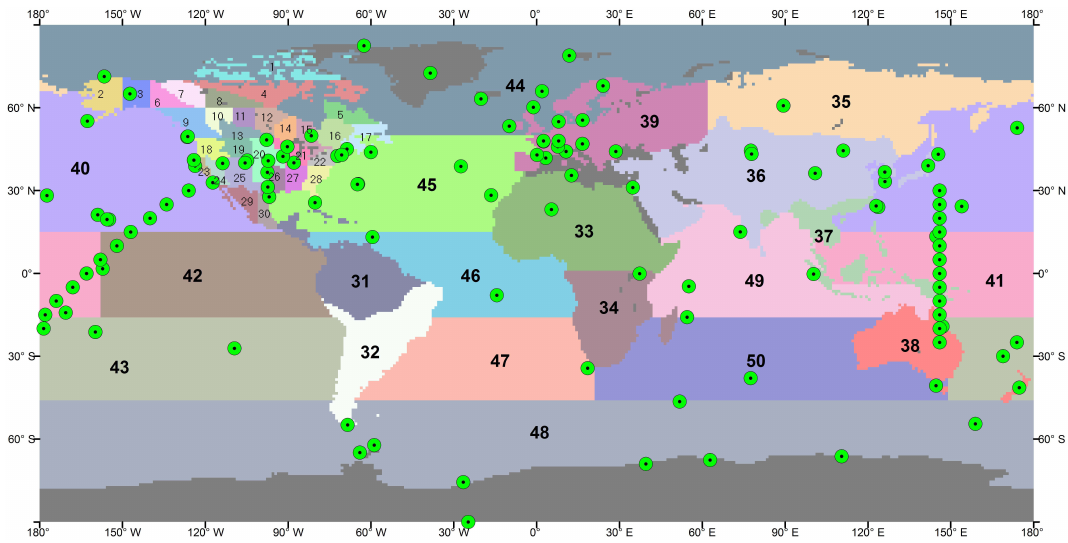
Fig. 1. An inversion scheme: 30 regions in North America and 20 regions for the rest of the globe. Locations of 210 CO 2 observational sites are also